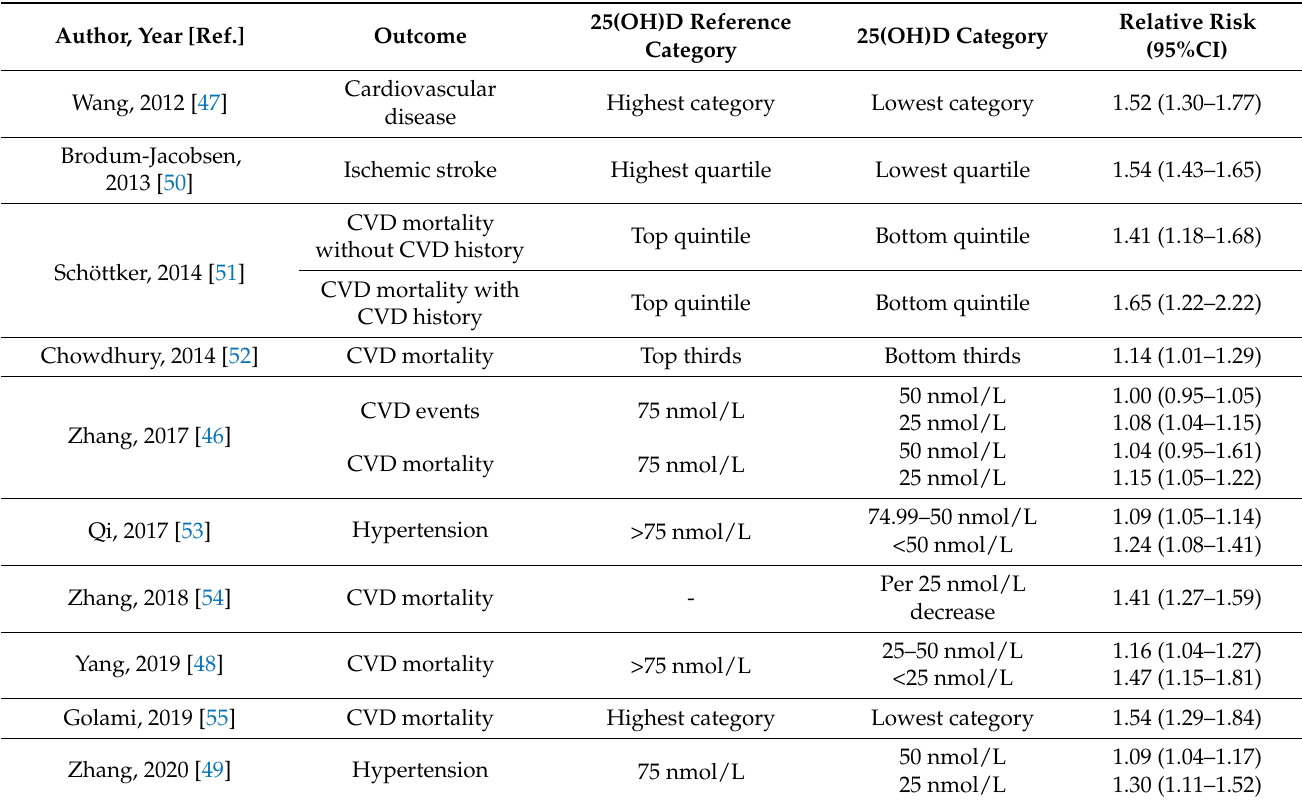
Table 1. Meta-analyses of observational studies on vitamin D status and cardiovascular